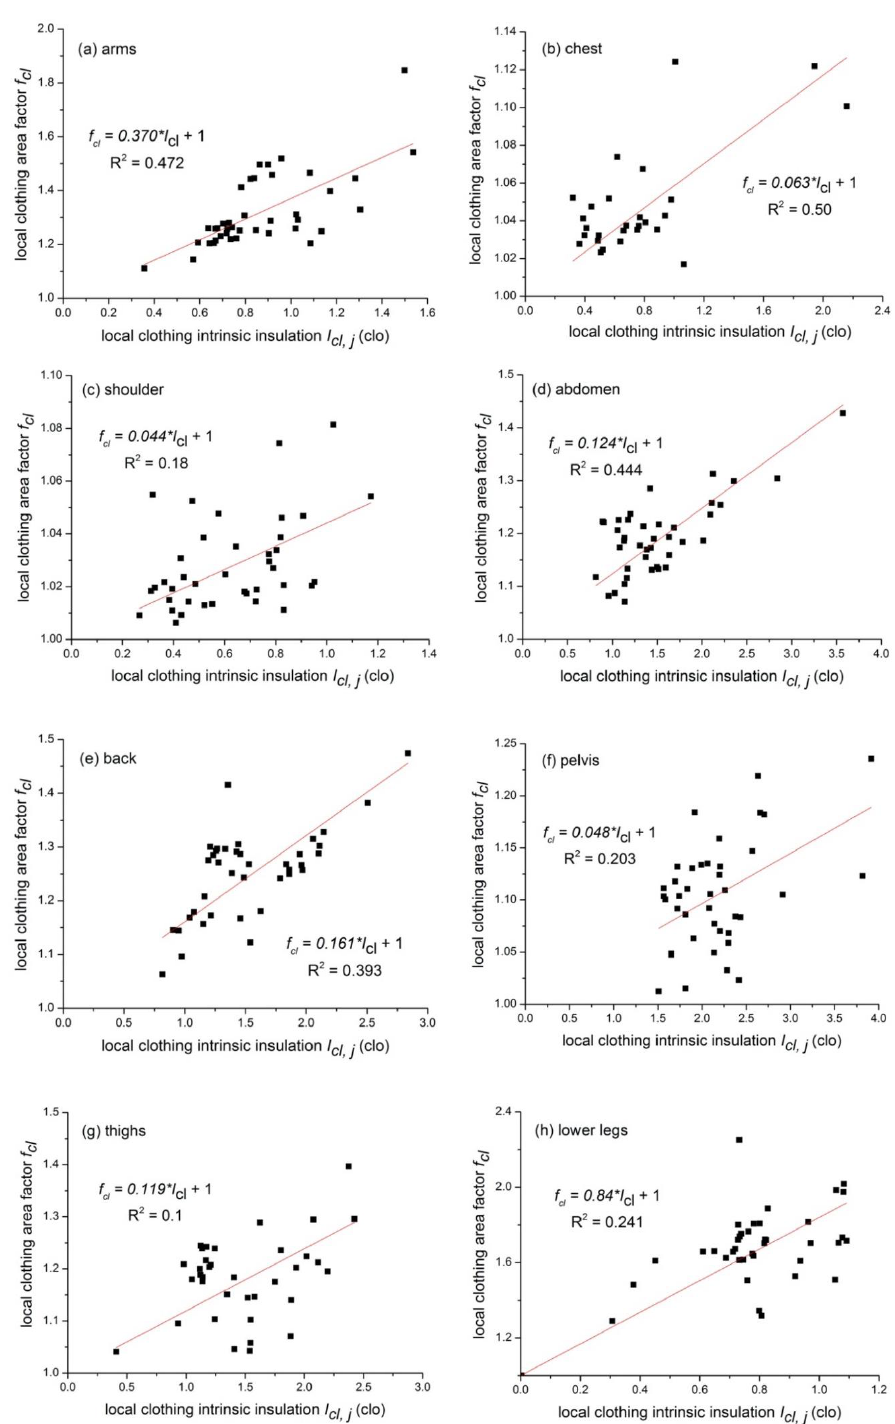
Figure 6. Relationships between the local I cl and local f cl for different body parts. ( a ) arms; ( b ) chest; ( c ) shoulders; ( d ) abdomen; ( e ) back; ( f ) pelvis; ( g ) thighs; and ( h ) lower legs.